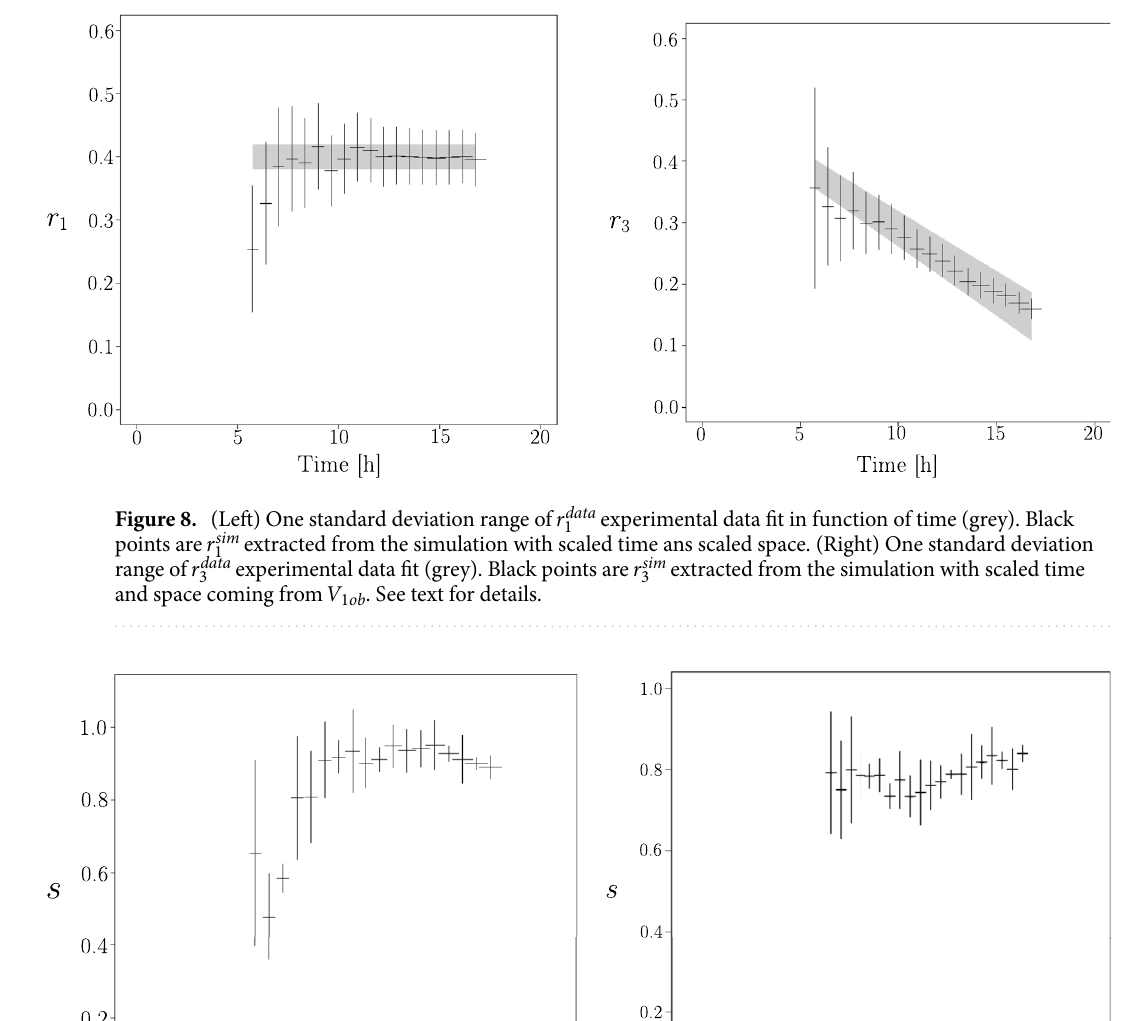
Figure 9. Sphericity of V 1 ob vertices distribution, defined as the ratio s = 2 (cid:31) 2 /( (cid:31) 1 + (cid:31) 2 ) of the eigenvalues (see the text for more details) in function of time. Right, sphericity extracted from the simulation, with scaled time and space. Left, is sphericity extracted from experimental